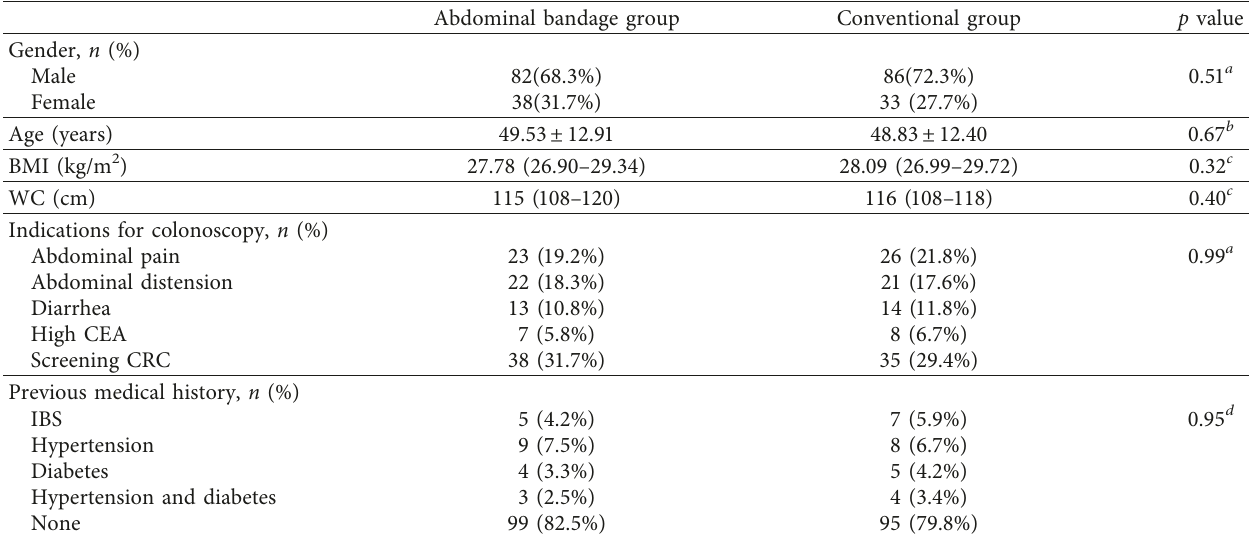
Table 1: Baseline characteristics.